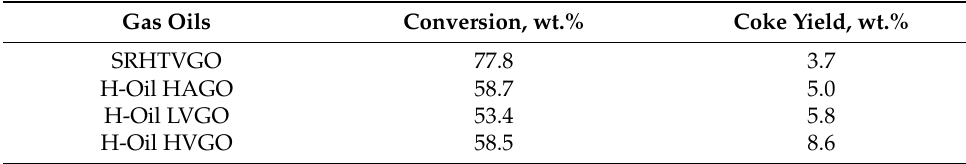
Table 3. Conversion of SRHTVGO, H-Oil HAGO, LVGO, and HVGO obtained in a laboratory ACE unit during the use of catalyst G. The quality of the cracked gas oils was identical to that shown in Table 1. Gas Oils Conversion, wt.% Coke Yield,